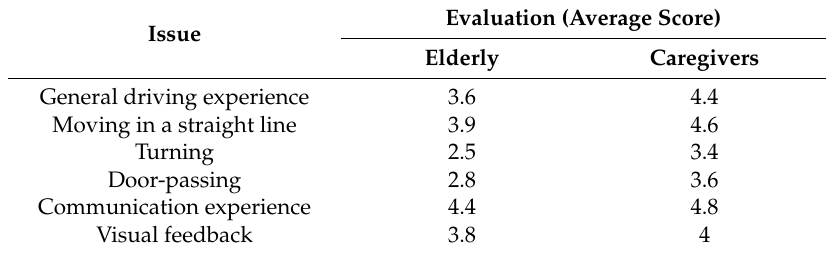
Table 4. Results of the evaluation of the different aspects of the driving and communication